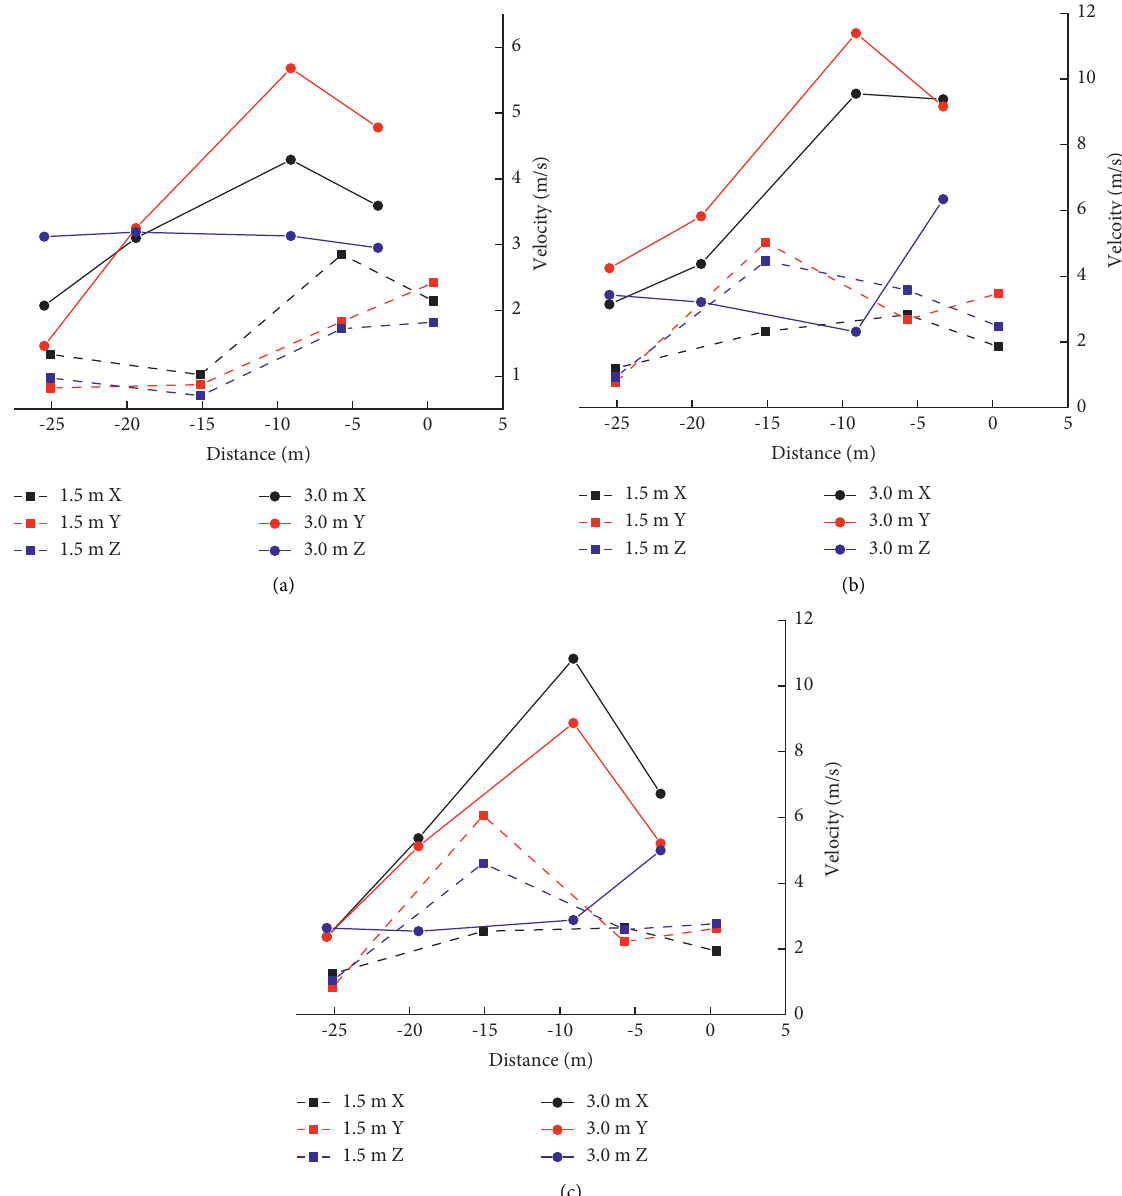
Figure 6: Comparison of 3D vibration velocities of typical blasting segments with different footage conditions behind the corresponding blasting face. (a) Cutting segment, (b) floor segment, and (c) contour